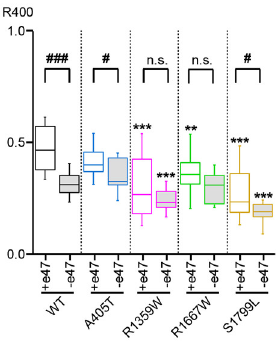
Figure 5. Cav2.1 inactivation kinetics. Box plot of the ratio of remaining current at the end of a 400